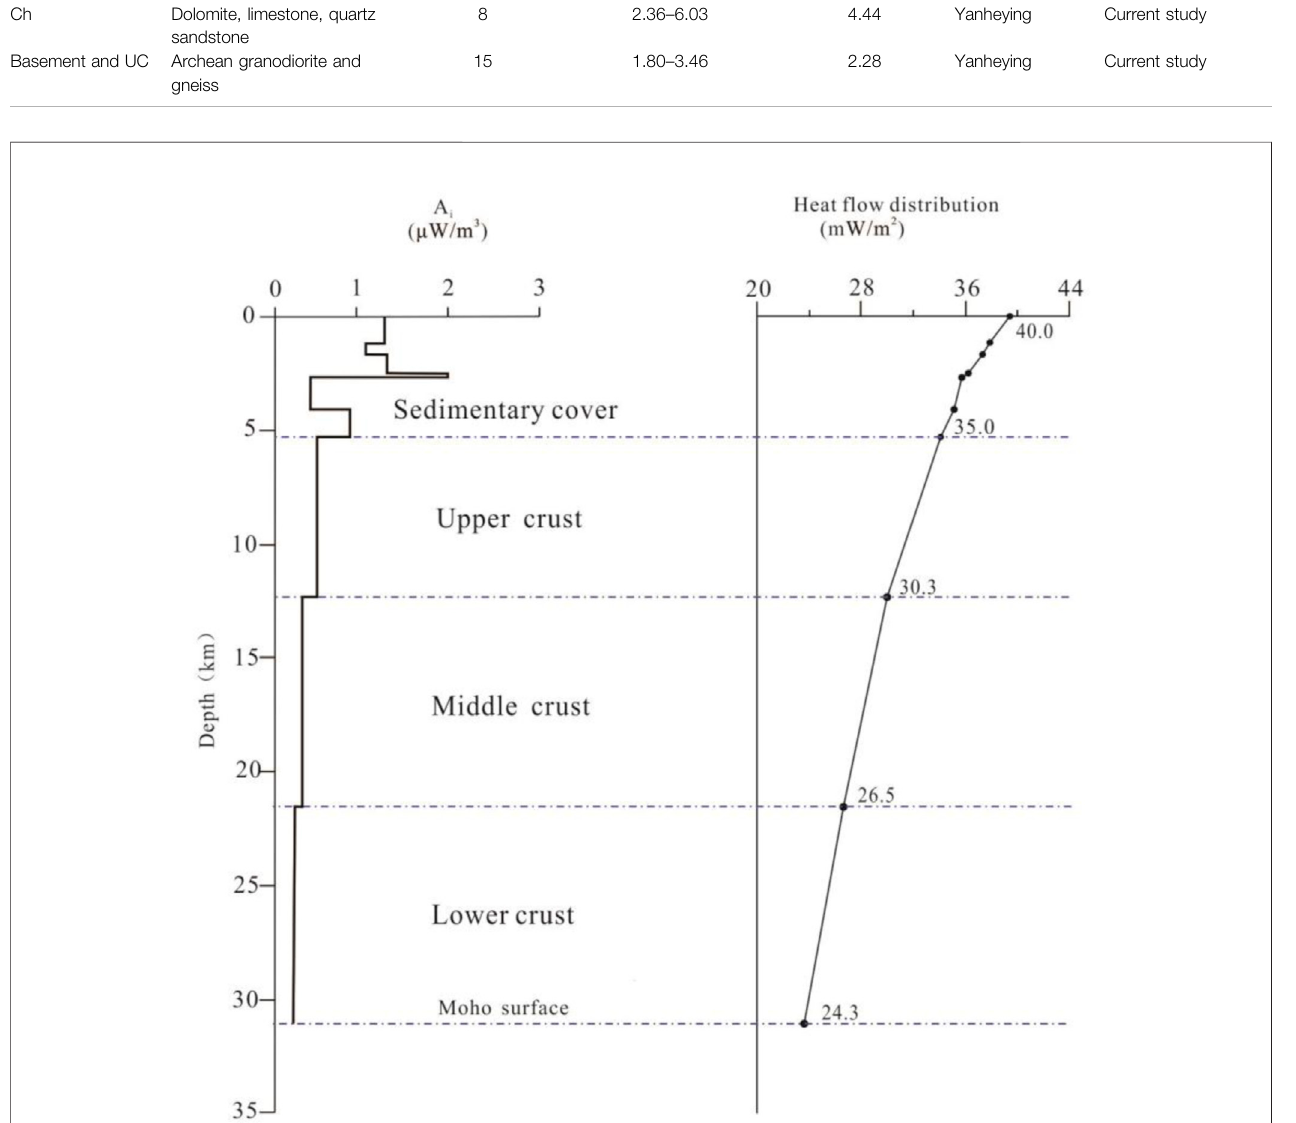
FIGURE 5 | Conceptual model of lithospheric thermal structure in the Yanheying Basin.